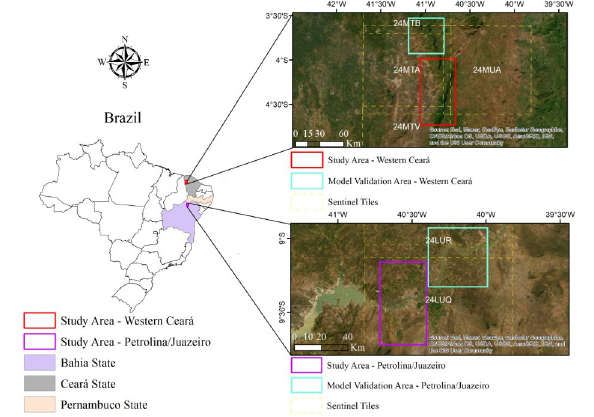
Figure 1 . Study areas.